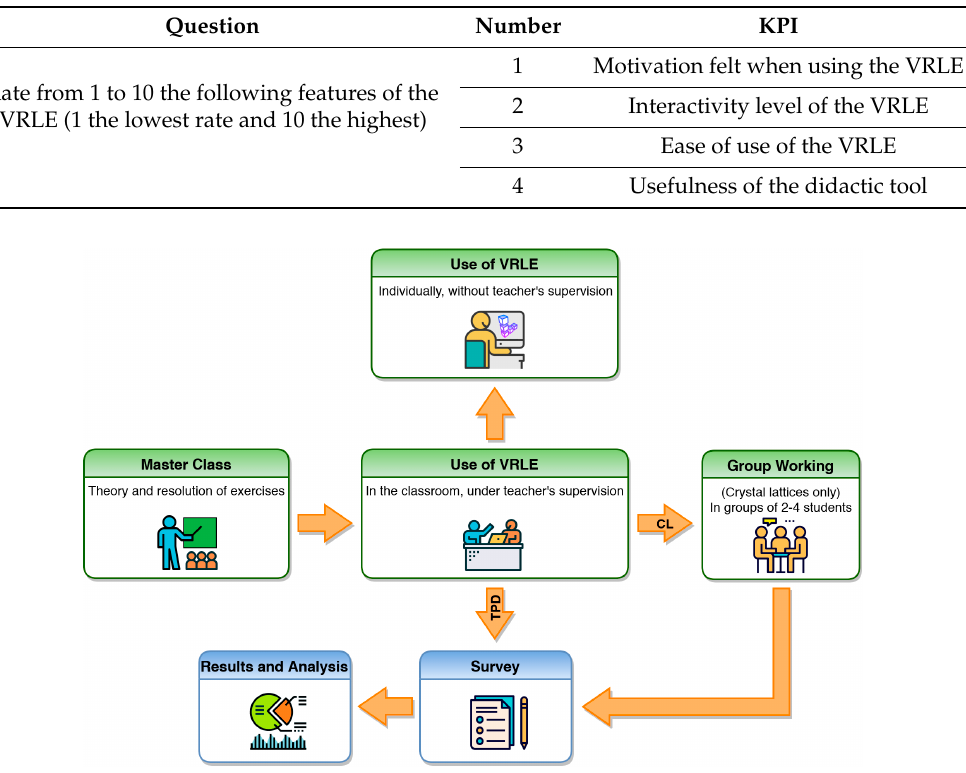
Figure 5. Procedure used to implement the VRLEs in the classroom.